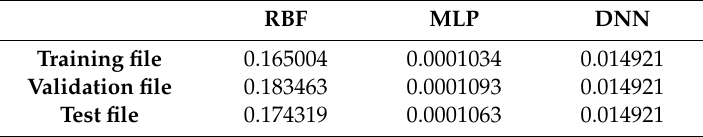
Table 2. Root mean square (RMS) errors for the RBF, MLP and